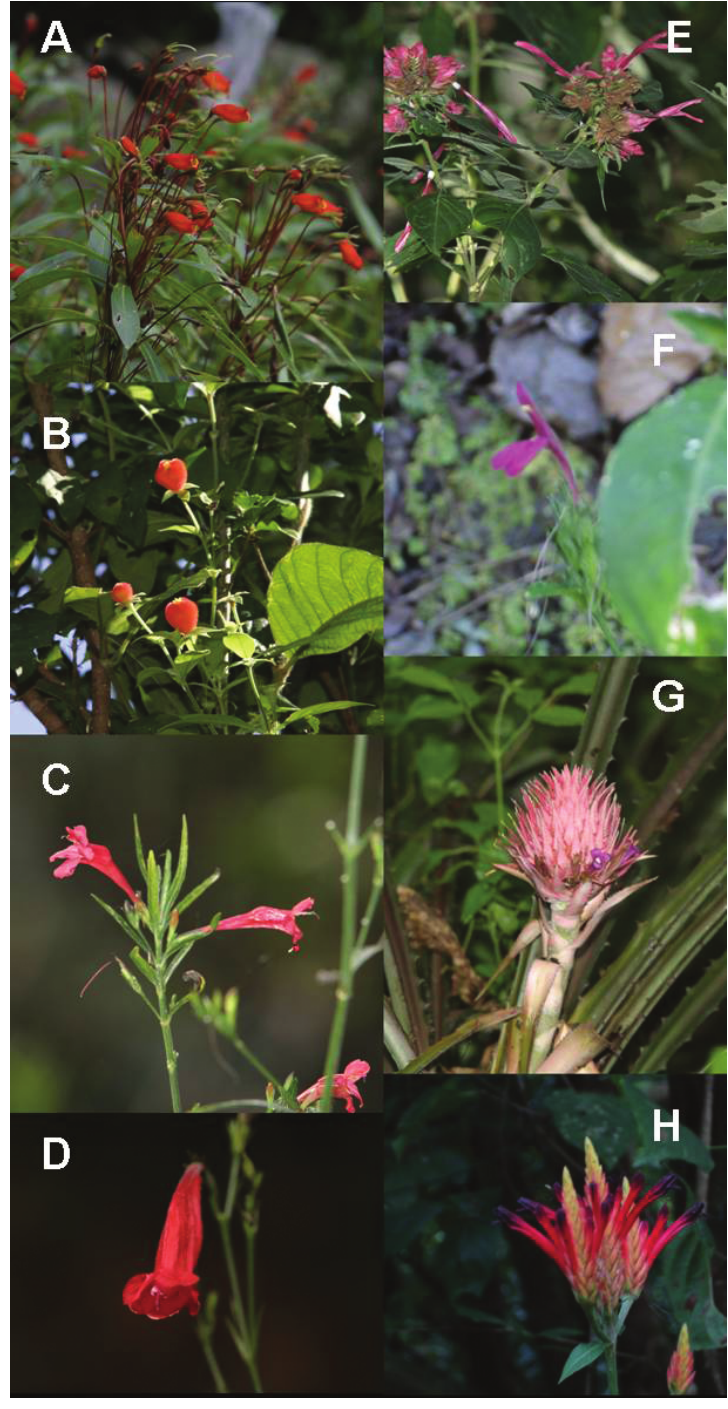
Fig. 5 – Ornithophilous species recorded at Serra da Bodoquena: A) Seemannia sylvatica , B) Manettia rojasiana , C) Ruellia angustiflora , D) Ruellia brevifolia , E) Lophostachys floribunda , F) Justicia ramulosa , G) Ananas ananassoides , and H) Geissomeria tetragona . Pictures by Eduardo Camargo (A, B, C, D, E, G) and Rogério Rodrigues Faria (F,